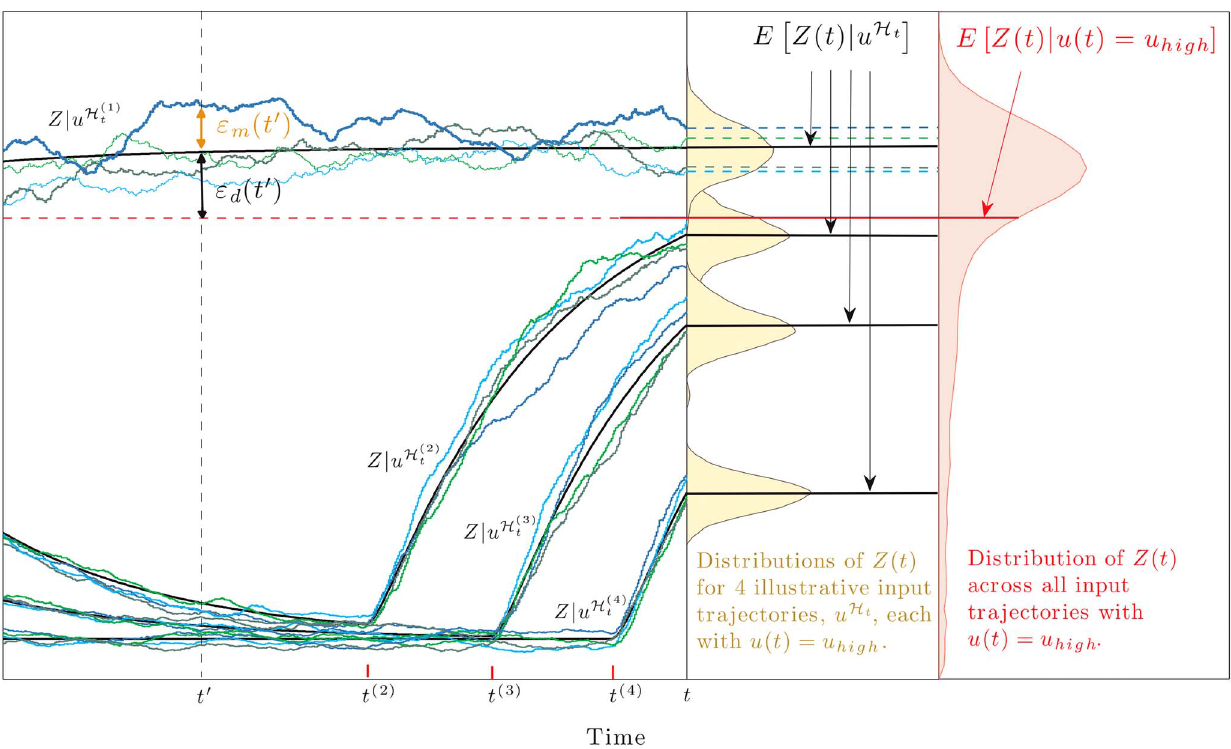
Figure 2. Dynamical error as the difference between two conditional expectations. To illustrate, we consider a 2-stage model of gene expression with the input, u ( t ) , equal to the current rate of transcription, and the signal of interest s ( t ) ~ u ( t ) . We model u ( t ) as a 2-state Markov chain and show simulated trajectories of the protein output, Z , corresponding to four different input trajectories, u H t . These input trajectories (or histories) all end at time t in the state u ( t ) ~ u high (not shown) and differ according to their times of entry into that state (labelled t (2) , t (3) , t (4) on the time axis; t (1) is off figure). E ½ Z ( t ) D u H t (cid:2) (black lines) is the average value of Z at time t given a particular history of the input u : the random deviation of Z ( t ) around this average is the mechanistic error e m (shown at time t ’ for the first realisation of Z ). E ½ Z ( t ) D u ( t ) (cid:2) is the average or mean value of Z ( t ) given that the trajectory of u ends in the state u ( t ) at time t . E ½ Z ( t ) D u ( t ) ~ u high (cid:2) (red line) can be obtained by averaging the values of E ½ Z ( t ) D u H t (cid:2) over all histories of u ending in u high . The mean is less than the mode of the distribution for Z ( t ) D u ( t ) ~ u high because of the distribution’s long tail. E ½ Z ( t ) D u ( t ) ~ u low (cid:2) , not shown, is obtained analogously. The dynamical error, e d , is the difference between E ½ Z ( t ) D u H t (cid:2) and E ½ Z ( t ) D u ( t ) (cid:2) and is shown here for the first trajectory, u H (1) t . Fig. 3B shows data from an identical simulation model (all rate parameters here as detailed in Fig. 3B).